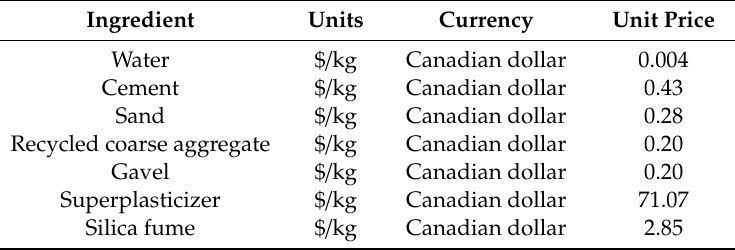
Table 7. Unit price of ingredients of concrete mixtures.